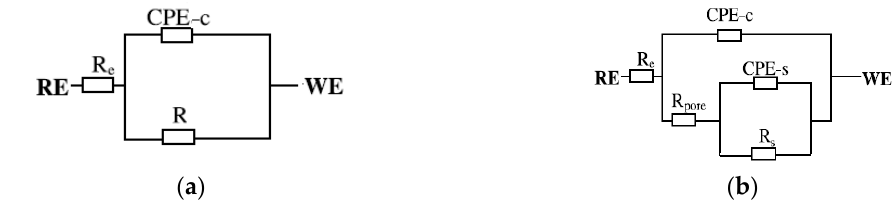
Figure 4. Equivalent electrical circuit models for: ( a ) one-time constant for uncoated alloy, ( b ) two-time constants for C1, C2 and C3 PVD coatings in NaCl and H 2 SO 4 solutions.